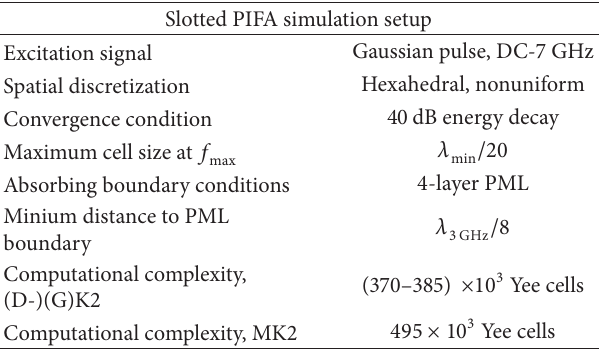
Table 1: Settings applied to the FIT-TS solver [32, 33] during the simulations of the slotted